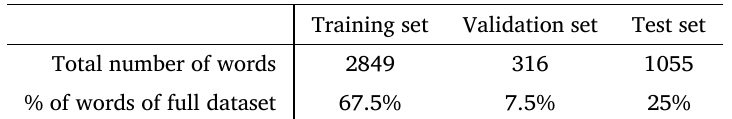
Training set Validation set Test set Transduction Total number of words 2849 316 1055 corpus statistics % of words of full dataset 67.5% 7.5%